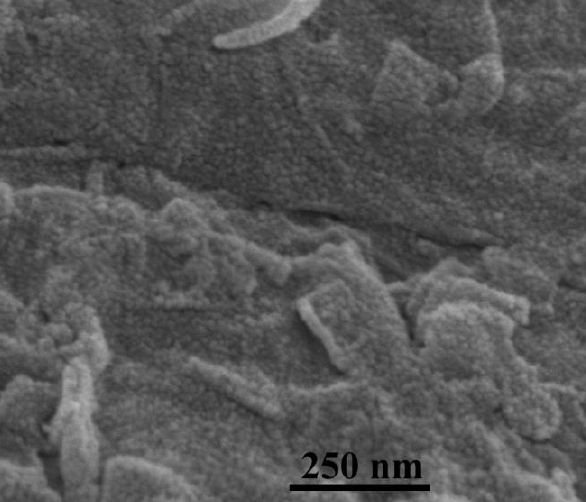
Figure 3. The SEM image of the fluorinated graphene sample.